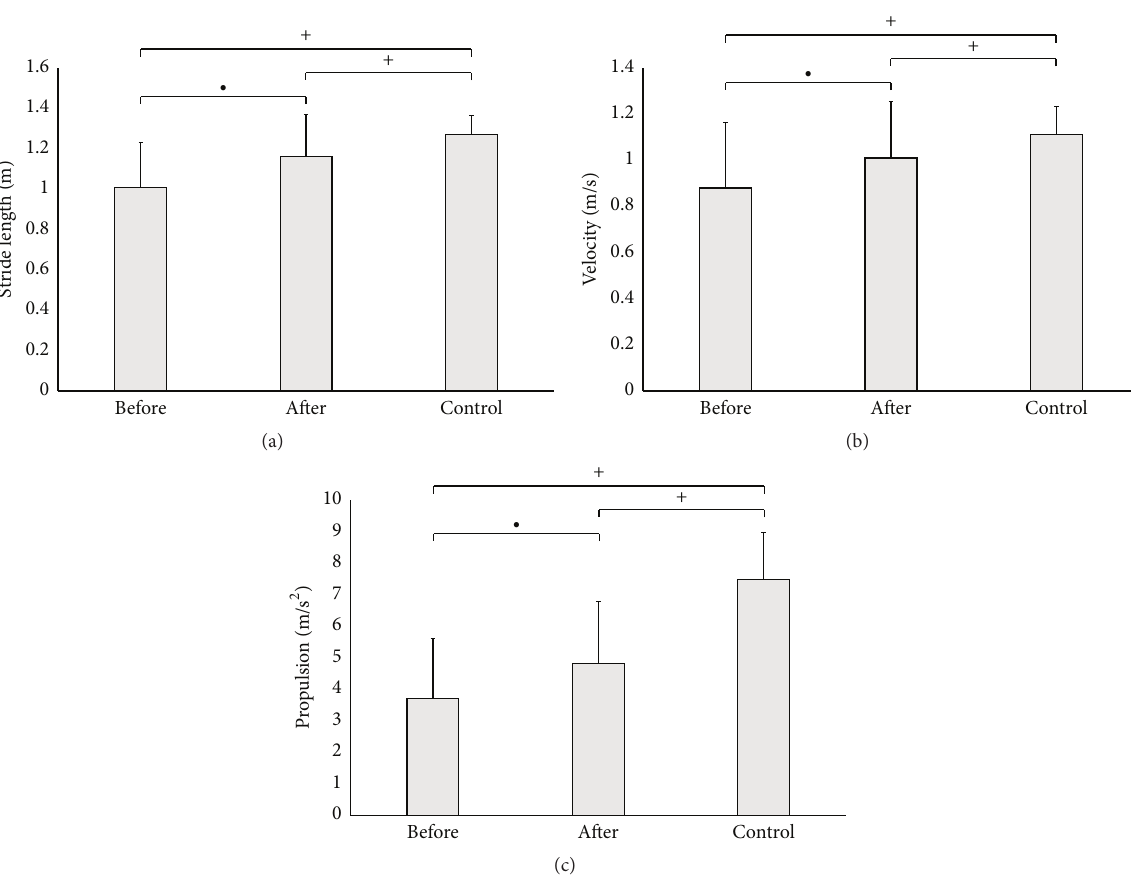
the correlation degree is as follows: 0.9 to 1 indicated a very high correlation; 0.7 to 0.9 indicated a high correlation; 0.5 to 0.7 indicated a moderate correlation; 0.3 to 0.5 indicated a low correlation; and 0 to 0.3 indicated little to no correlation.